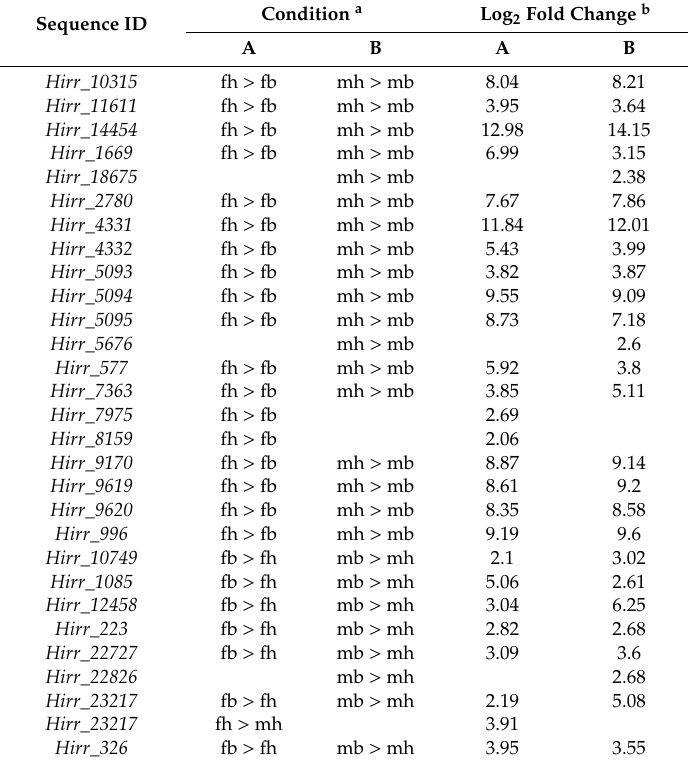
Table 2. Di ff erentially expressed candidate odorant binding protein (OBP) genes in fed, mated adult horn flies.